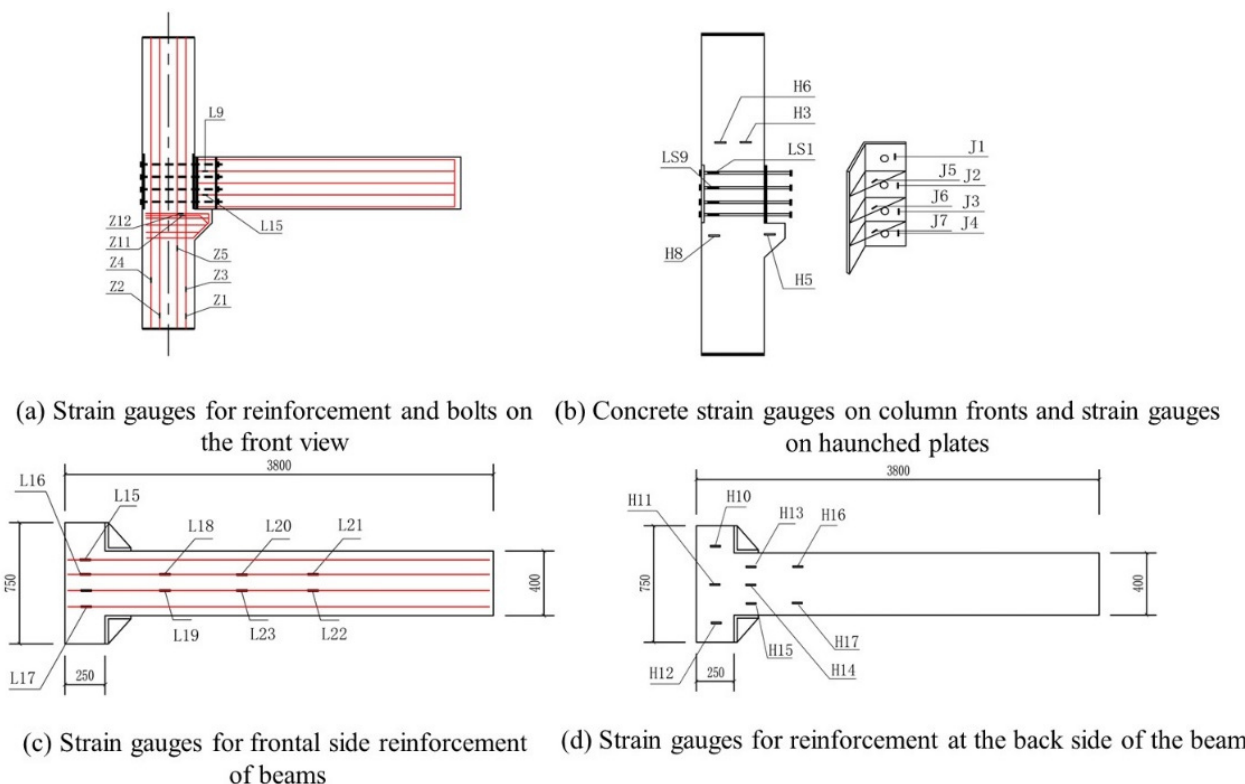
Figure 9. Strain gauge arrangement of the test piece reinforcement.